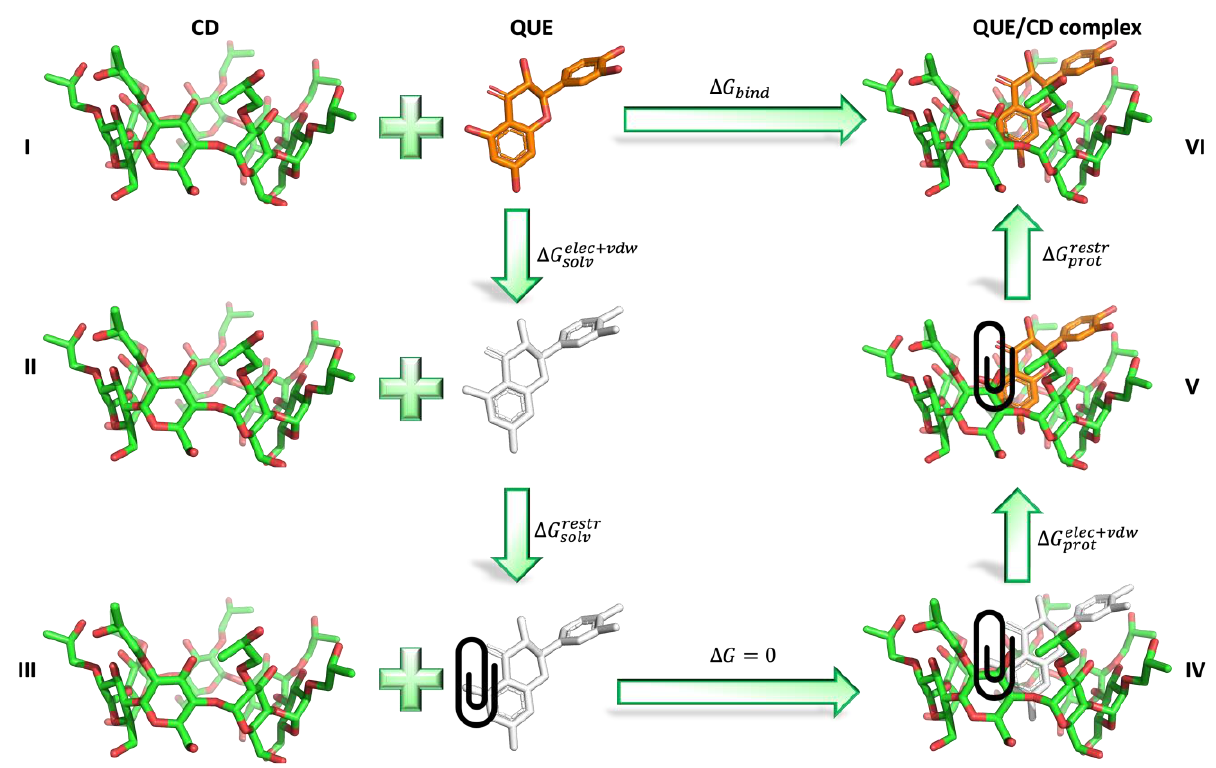
Figure 11. Thermodynamic cycle for absolute binding free energy calculations. QUE in solution (state I) is depicted as orange sticks and CD as green sticks. The presence of restraints is indicated with a paperclip. QUE depicted with white sticks means that the molecule is decoupled from the solvent.